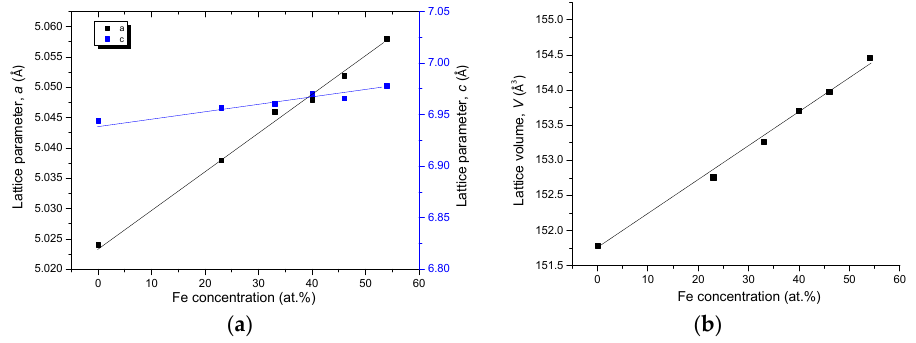
Figure 18. Cell parameters a and c ( a ) and lattice volume V ( b ) with Co concentration for the Ce(Co, Fe) 4 B from KAs 2–6.